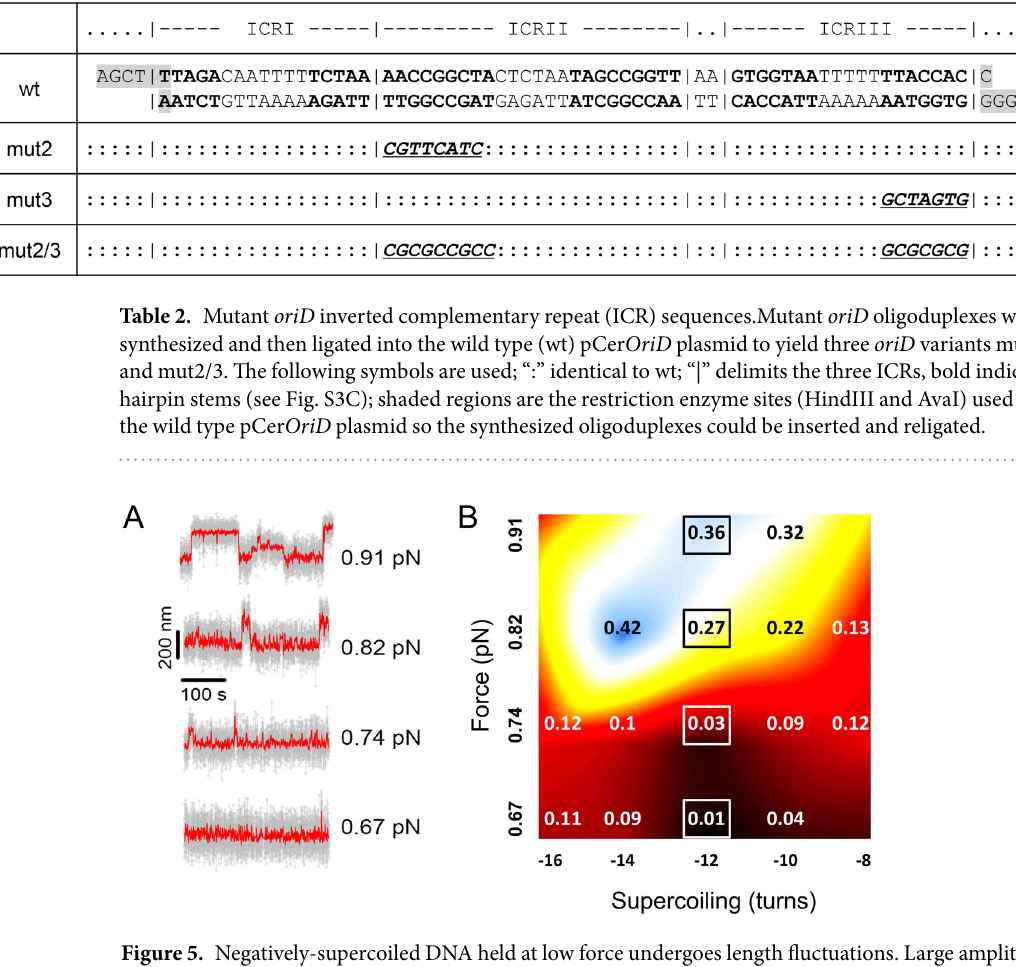
Figure 5. Negatively-supercoiled DNA held at low force undergoes length fluctuations. Large amplitude length fluctuations occurred when 4 kbp, oriD -containing, DNA templates were negatively supercoiled (by − 8 to − 16 turns) and held at 0.67 to 0.91 pN load. ( A ) Example traces showing DNA length fluctuations at − 12 turns of supercoiling and a range forces. Grey points are raw data and red lines (overlaid) are the running average of 25 points. ( B ) Data point values show the fraction of time the DNA molecule spent at the extended length at different forces and supercoiling levels. Pseudo-color coded background (from black to blue) is an interpolated heat-map to illustrate the fraction of time in the alternative state at each load and supercoiling level. The data points were obtained by histogramming z-displacement data (from 20–25 molecules, recorded for > 300 seconds for each condition) so that the proportion of time spent in the extended state could then be determined by fitting to a dual Gaussian function (see Fig. S3 for details). The boxed values are from the same conditions as the raw data records in ( A ). The SEM of each point is around ± 0.05. Experiments were performed at 23 °C, K100 + buffer.